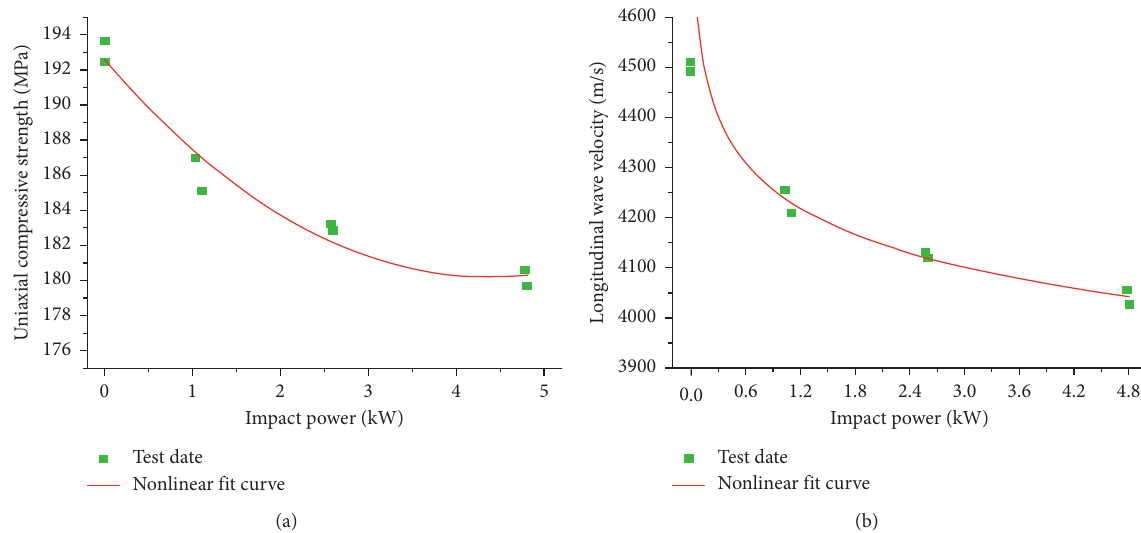
Figure 11: Variation of uniaxial compressive strength and longitudinal wave velocity with impact power: (a) variation curve of uniaxial compressive strength and (b) variation curve of longitudinal wave velocity.